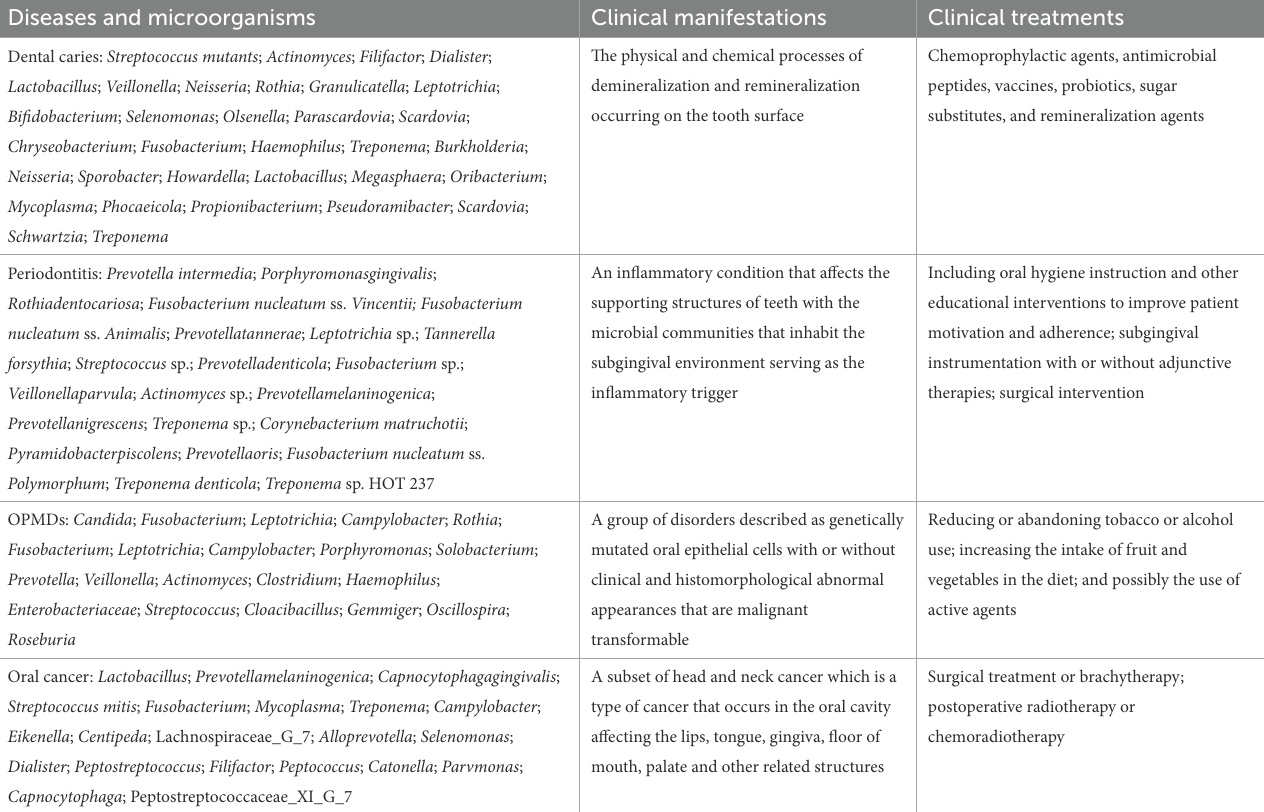
TABLE 2 Oral species implicated in oral